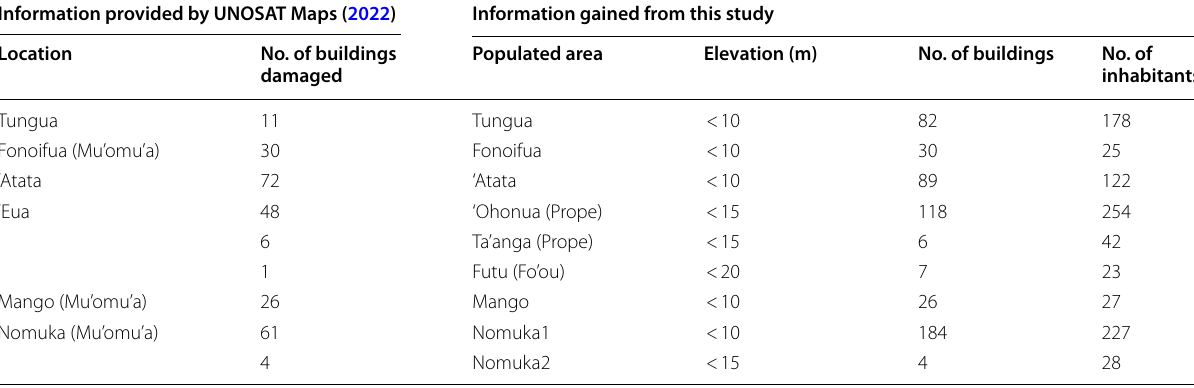
Table 5 Comparison of damages to buildings in specific populated areas Information provided by UNOSAT Maps (2022)